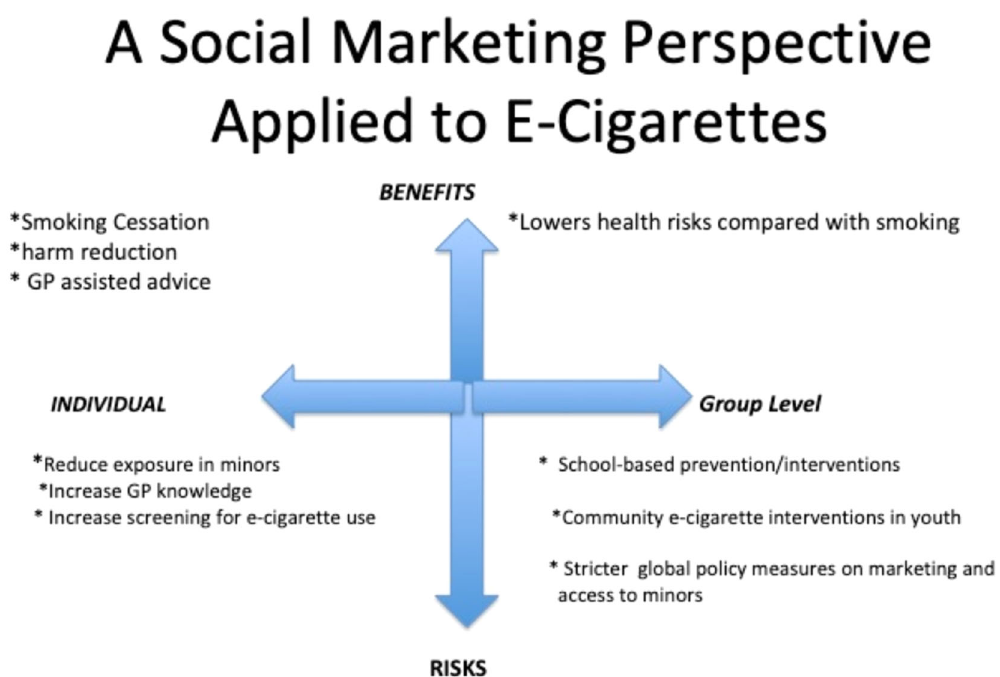
Fig. 5 Strategies to reduce the harm and maximize the bene fi ts associated with e-cigarettes at the individual and group levels 82,96,97,123 . The North Axis represents the bene fi ts of e-cigarettes for smokers and the South axis represents the risks, while the East and West axes represent the strategies that may be adopted at an individual level and community/population level. By maximizing the bene fi ts in select adult smokers through harm reduction and minimizing the risks of exposure in minors, e-cigarettes may be safely used.